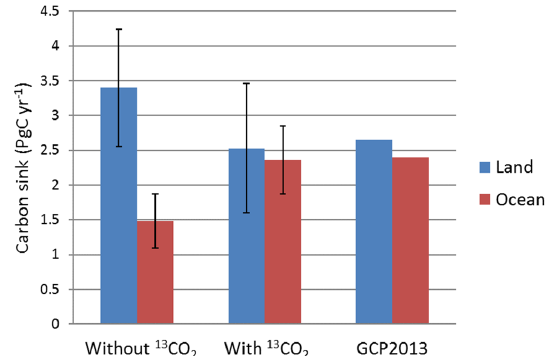
Figure 7. Comparison of land and ocean carbon sinks derived from inversions with and without the 13 CO 2 constraint against the Global Carbon Project results (Le Quéré et al., 2013).